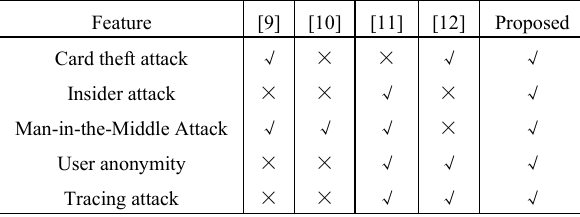
Table 3. Security features comparison